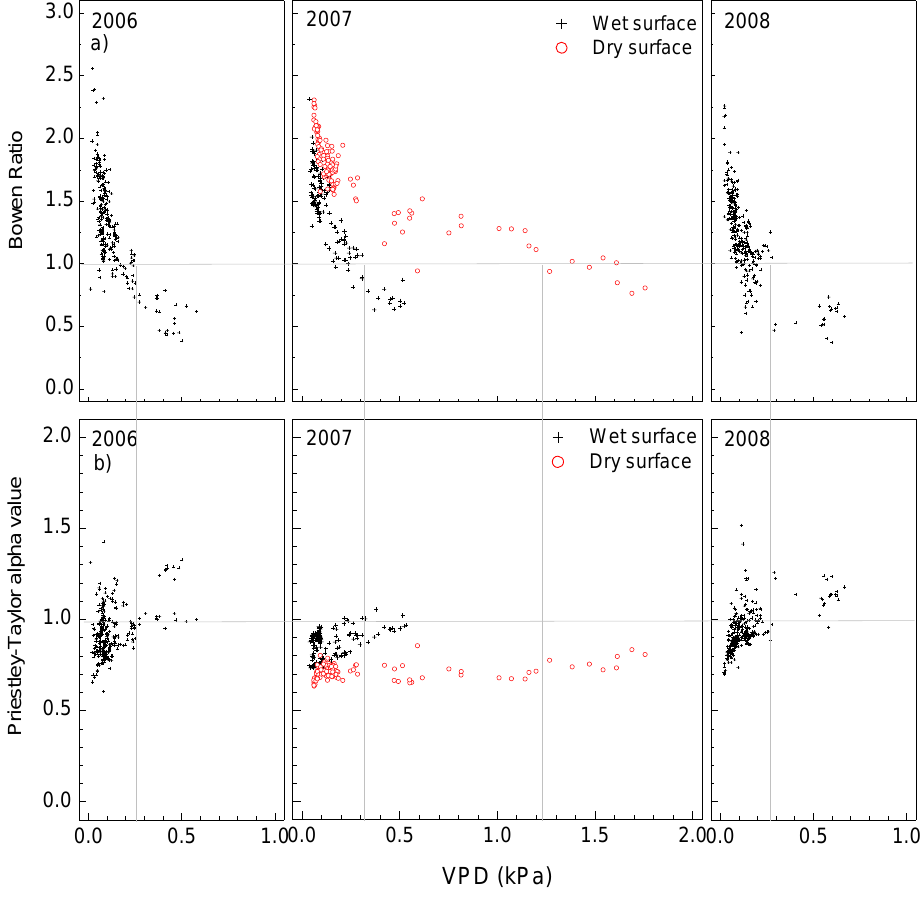
Fig. 5. The relationship between mean hourly air vapor pressure deficit (VPD) and (a) Bowen ratio ( β ) or (b) Priestley-Taylor α during differing soil moisture conditions at the BE site, 2006–2008. Dry soils represent a soil water potential < − 0.13MPa at 10cm depth. The vertical dashed lines represent the identified critical value of VPD. VPDs above this threshold resulted in a β < 1 and a Priestley-Taylor α near or above 1. The identified VPD thresholds were 0.25 (2006), 0.31 (2007), and 0.28kPa (2008) for wet soils and 1.19kPa for dry soils